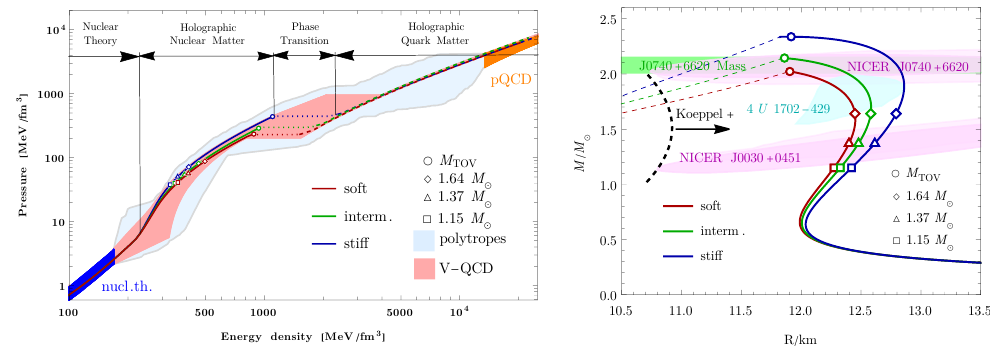
Figure 1: Left: Cold, beta equilibrium slices of the V-QCD EOS. Shown are the Soft (red), Inter (green) and Stiff (blue) versions of the model. Dark blue and orange bands mark the uncertainties in nuclear theory [ 18 ] and perturbative QCD [ 19 ] cal- culations, respectively. The light blue region marks the theoretically allowed region spanned by polytropic EOSs, where the pink region marks the parametric freedom of V-QCD after imposing constraints from NS observations. Right: Corresponding mass-radius relations where dashed lines mark unstable quark matter branches. In addition we show various error bands of direct mass [ 20, 21 ] and radius [ 22–26 ] measurements of heavy pulsars; shown with a black dashed line is a theoretical lower bound for the radii as computed from considerations on the threshold mass by Koep- pel et al. [ 27 ]